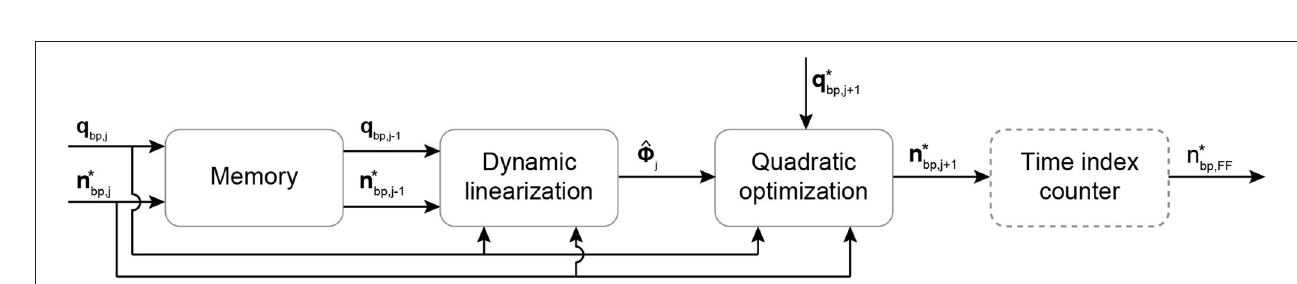
FIGURE 4 | Schematic overview of the DD-ILC algorithm. The pump speed setpoint and the PF are stored in a memory block. Then, they are used at the beginning of each cycle to update the system model through dynamic linearization. The model is used in a quadratic optimization problem to minimize the PF tracking error under pump speed constraints. The time index counter operates continuously to extract and output the feedforward pump speed setpoint at every time step within an iteration. Bold letters define vectors. n * bp , j , pump speed setpoint vector of the j th cycle; q bp , j , measured PF vector of the j th cycle; ˆ Φ j , pseudo partial derivative denoting the linearized system model; q * bp , j + 1 , PF reference trajectory; n * bp , FF , feedforward pump speed setpoint in the time